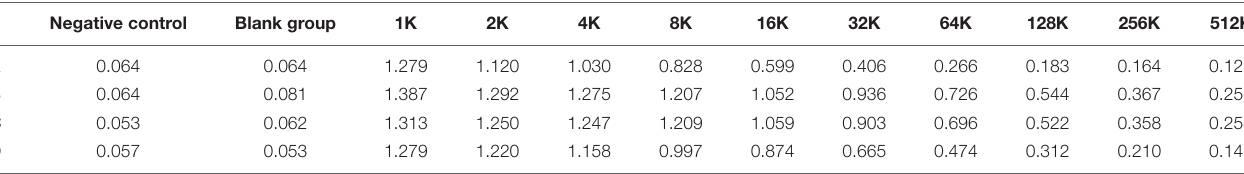
TABLE 2 | Determination of antibody titer.